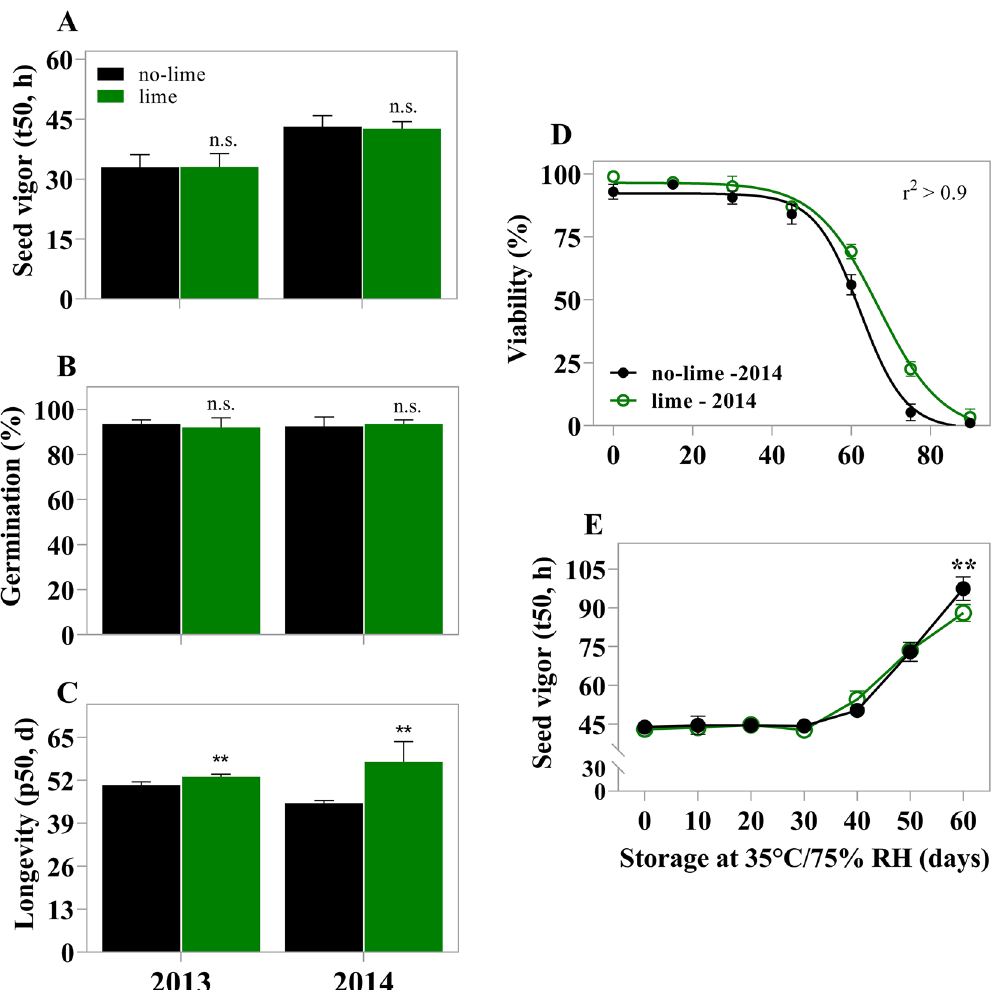
Figure 1. Physiological quality of wheat seeds produced without liming and with lime application at a rate of 2000 kg ha −1 . ( A ) Seed germination of normal seedlings. ( B ) Seed vigor (t50). ( C ) Values of p 50 in wheat seeds produced with and without lime. ( D ) Germination of wheat seeds from the 2014 season produced with and without lime collected at different times during storage, fitted using the Boltzmann equation parameters [ y = top + (bottom-top)/1 + [ v 50 − ( x /slope)]; r 2 > 0.9 for both groups: lime and non-lime]. ( E ) Seed vigor (t50) during storage in seeds from the 2014 season produced without and with lime. Data points are averages of eight replicates of 50 seeds each, and bars represent standard deviation. The two asterisks represent the significance at 0.05-confidence level by the t test between lime and no-lime. n.s. not